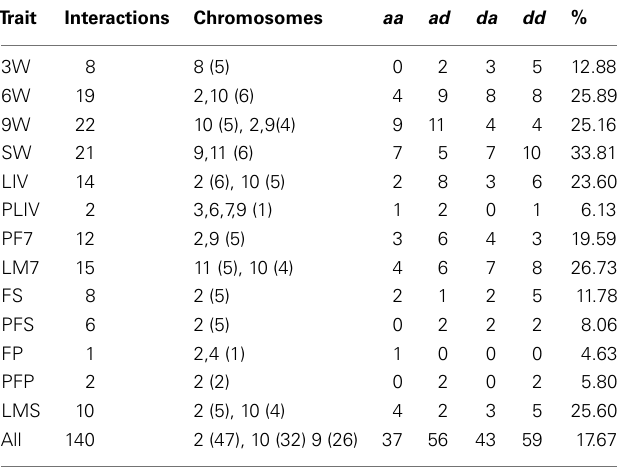
Table 1 | Summary of epistatic interactions affecting the weight and adiposity